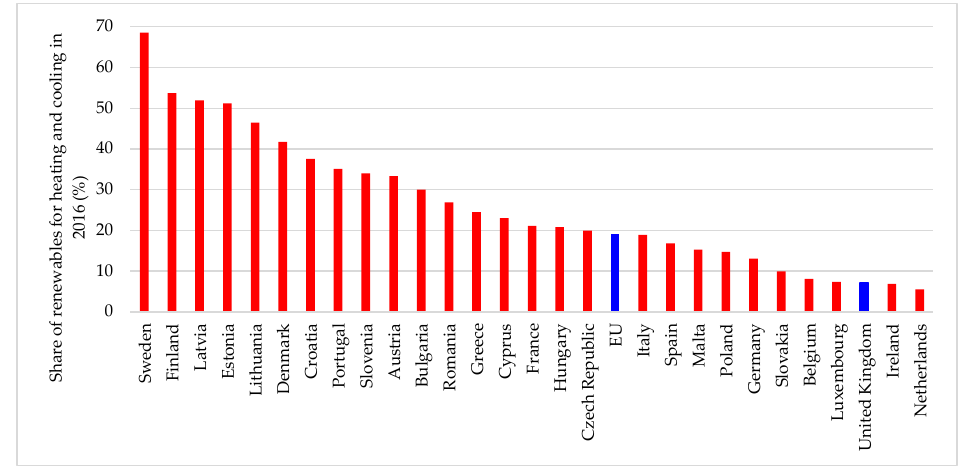
Figure 1. Shares of renewable energy sources used for heating and cooling for the EU and its 28 member countries in 2016 [8].